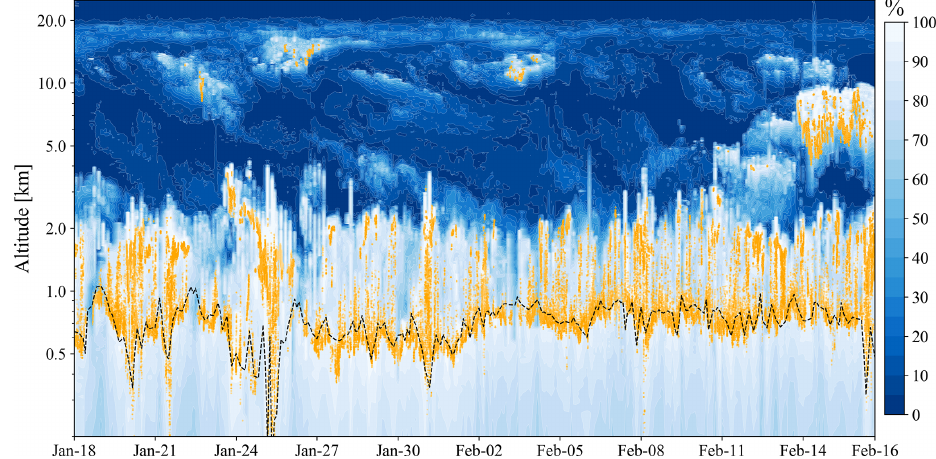
Figure 9. Comparison between ascending and descending soundings and ceilometer measurements on Meteor . The relative humidity from radiosonde measurements is shown in blue-to-white shading. The dashed black line represents the lifting condensation level calculated based on Bolton (1980). Cloud base heights as observed by the ceilometer are marked with orange dots. The vertical axis is chosen to be logarithmic for better visibility of the moisture distribution near the surface. The time axis for the soundings uses launch time. The temporal resolution of the ceilometer data is 10s. Low-altitude relative humidity profiles (300–800m) of the descending soundings were recovered by assuming a dry adiabat temperature and a constant humidity